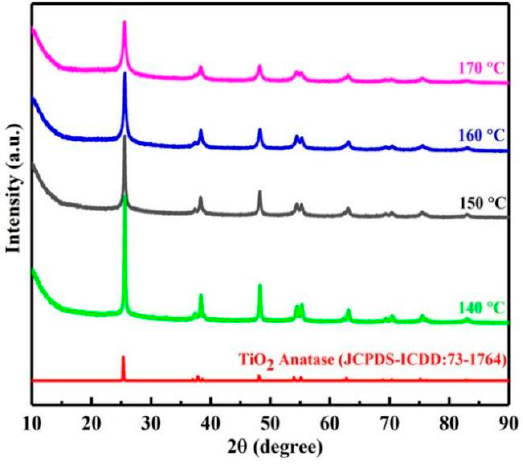
Figure 3. XRD of products at different temperatures.